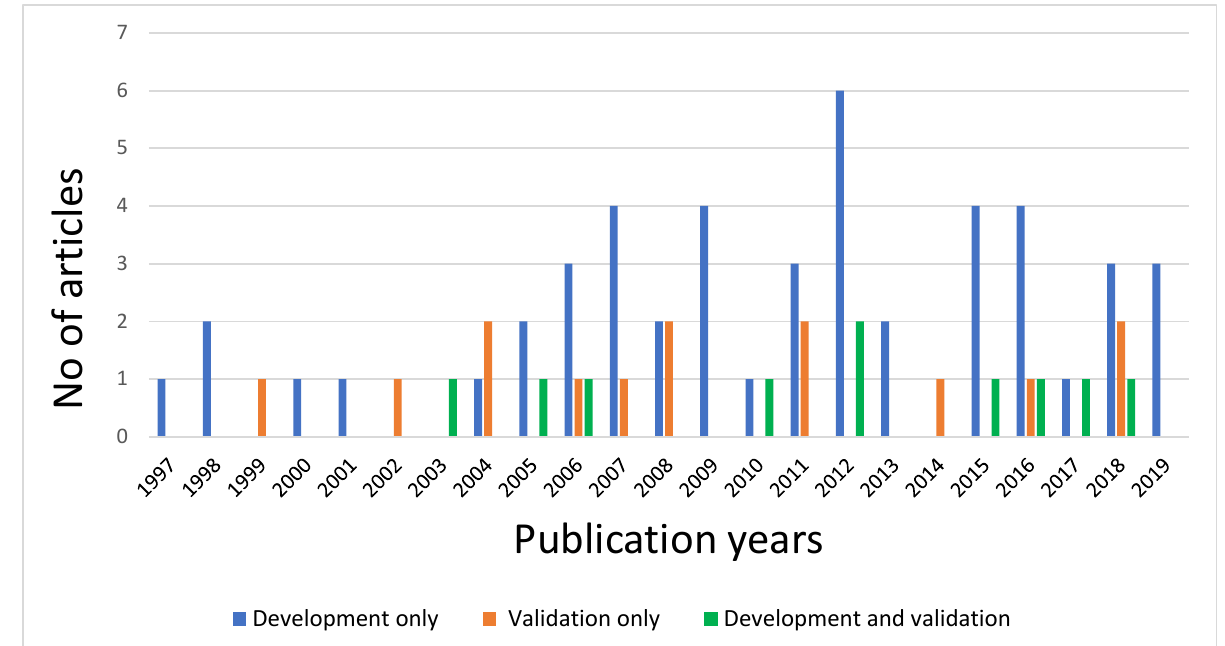
Figure 2. Numbers of publications on prognostic models included per year.